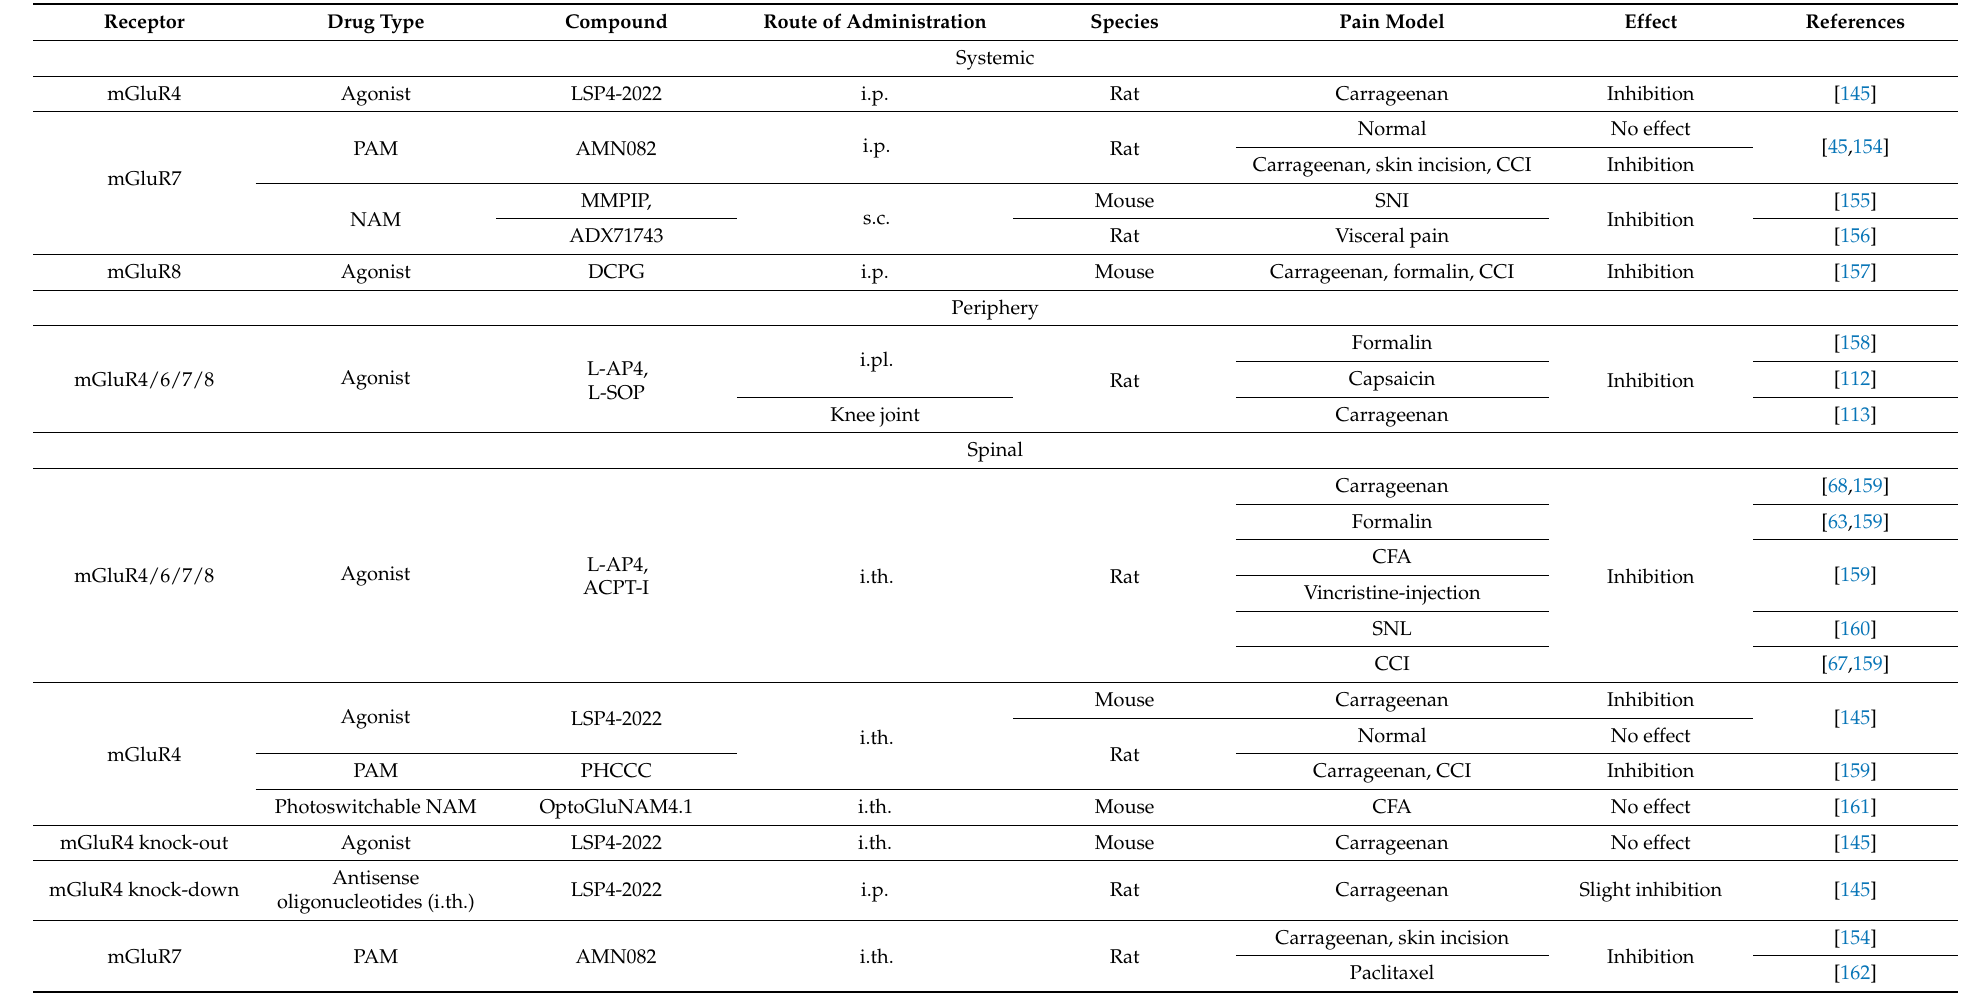
Table 3. Behavioral effects of group III mGluR drugs in preclinical pain